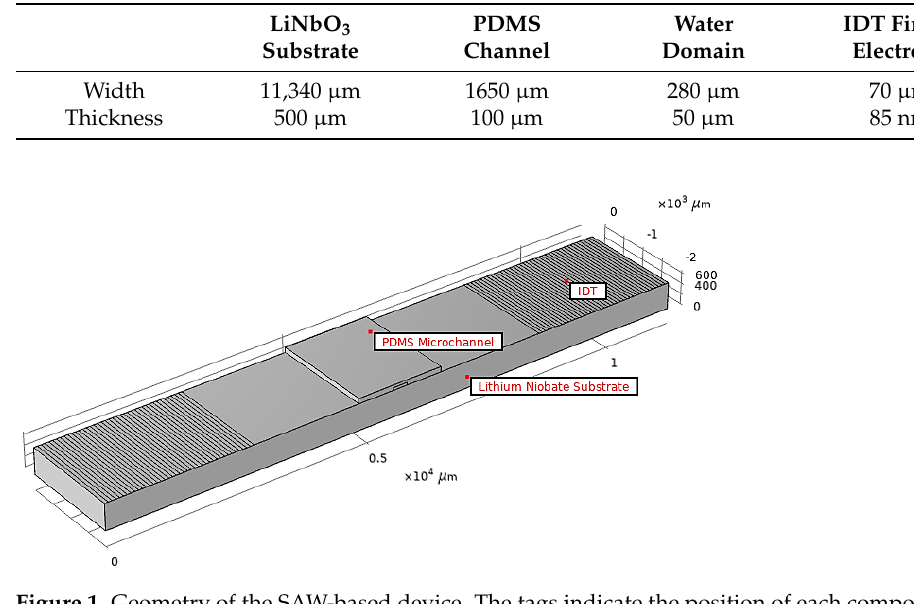
Figure 1. Geometry of the SAW-based device. The tags indicate the position of each component.